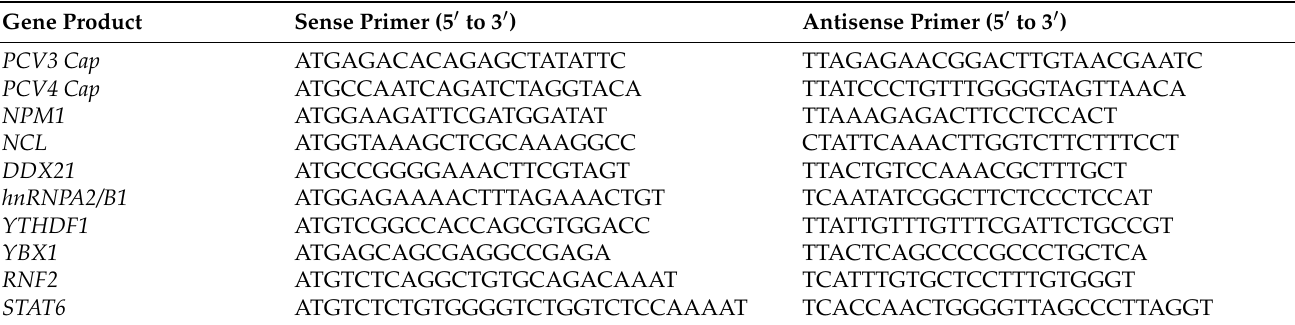
Table 1. List of primers used for cloning in the